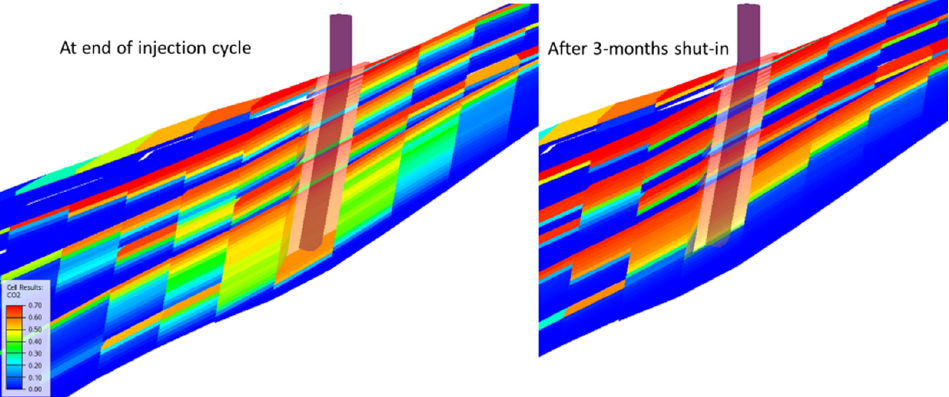
Figure 21. CO 2 saturation near-well-bore at end of injection cycle and after following three-month shut-in.